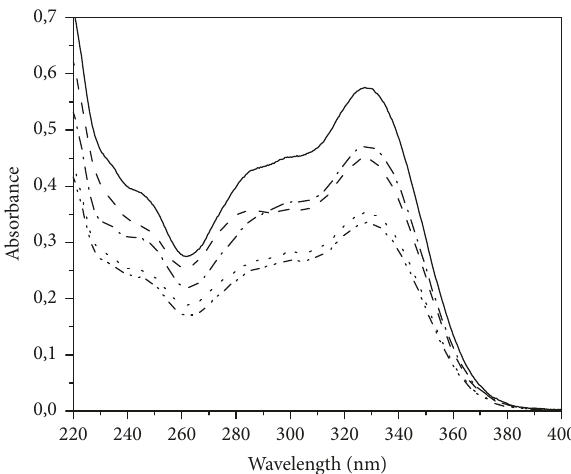
Figure 4: UV/Vis absorption spectra of A1 (dash dot), A2 (dash dot dot), A3 (dot), R1 (continuous), and R2 (dash) coffee chemical extraction.